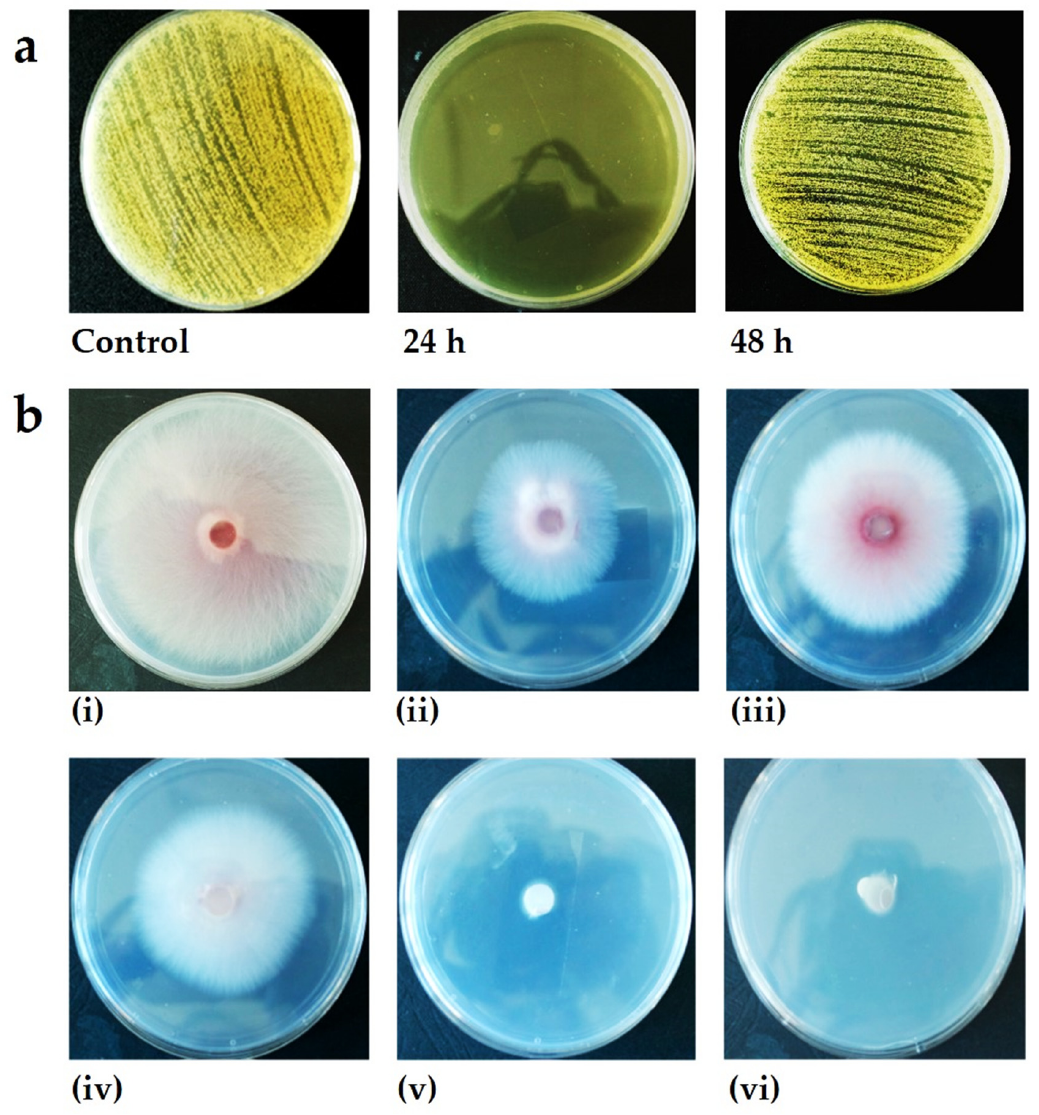
Figure 5. Inhibition of fungal cultures exposed to selected volatile organic